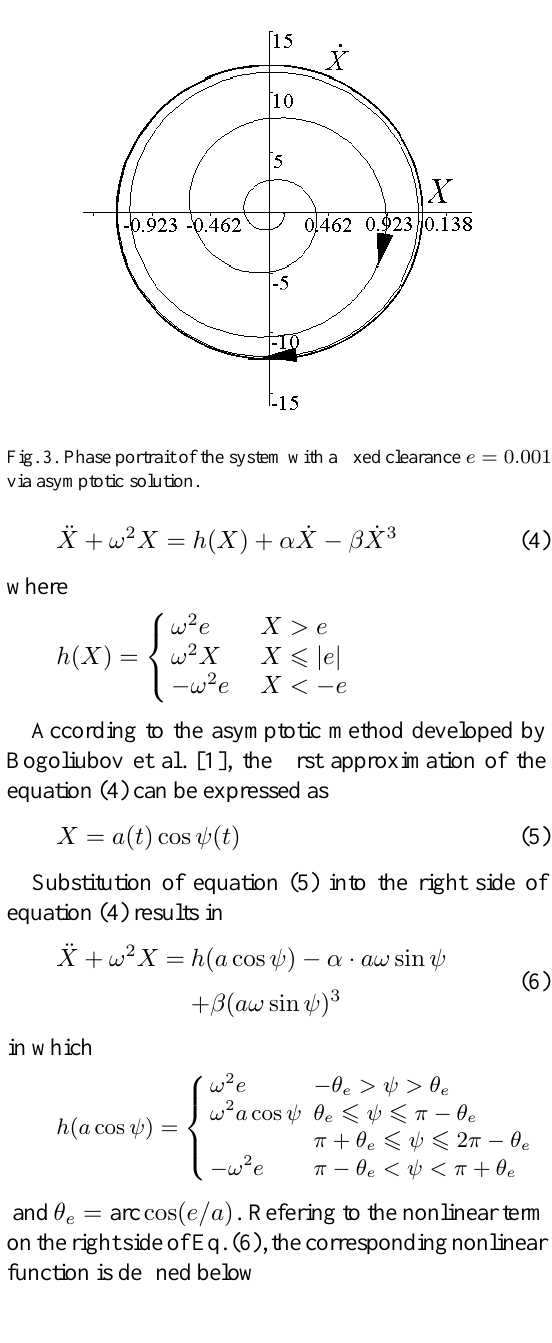
Fig. 1. A simplified model of the rolling mill. Fig. 2. Expression of piece-wise restoring force.